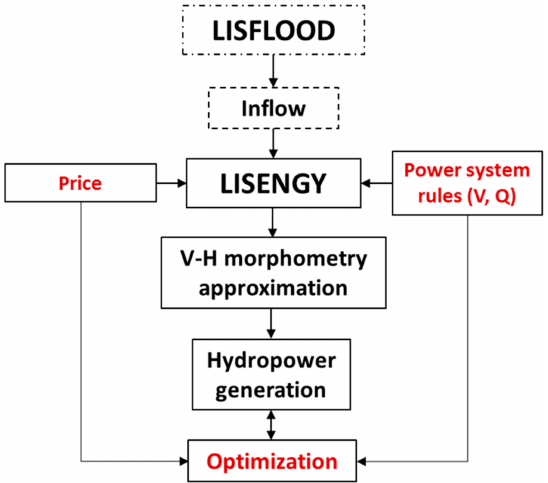
Figure 5. The proposed modeling framework (dashed lines: the LISFLOOD model and its inflow component; solid lines: the LISENGY components; in red: the optimization and its